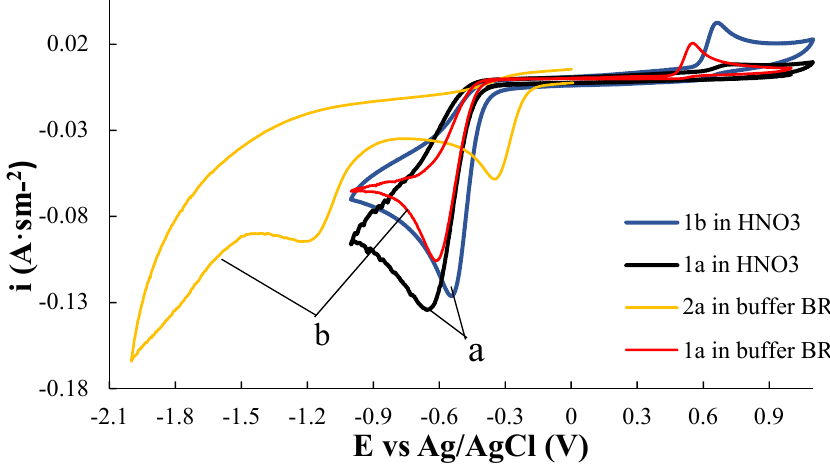
Figure 1. CVs of 5 mM compounds 1a and 1b in 0.1 M HNO 3 (a) and (2a) and (1a) in a BR buffer solution (pH 2) (b) using glassy carbon electrode (GCE). V = 50 mVs − 1 . Potentials were measured relative to Ag/AgCl/KCl sat .